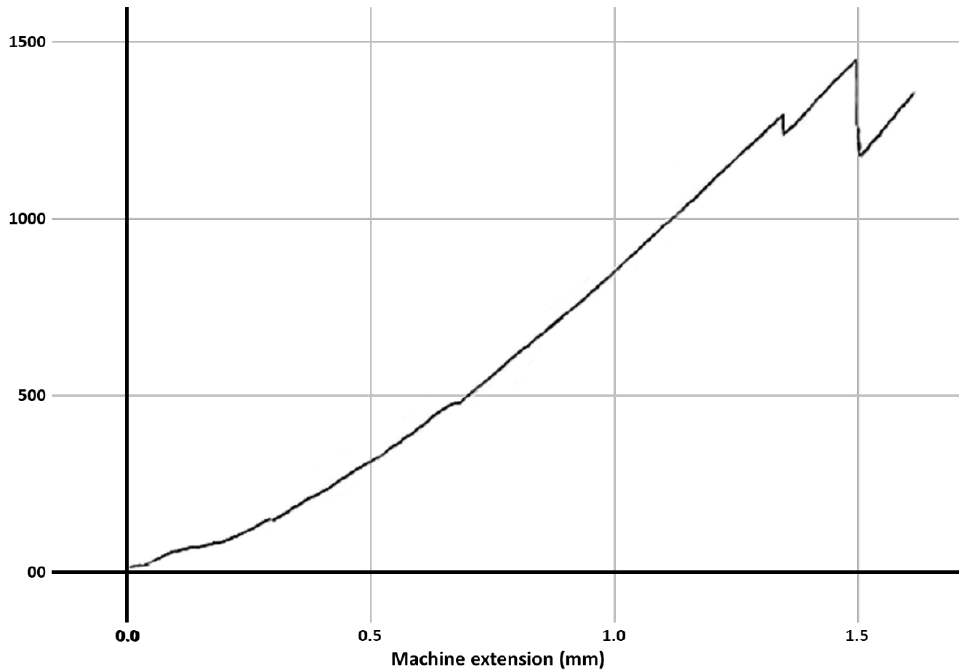
Figure 4. The maximum value of the force at which the most resistant molar from Group C failed.